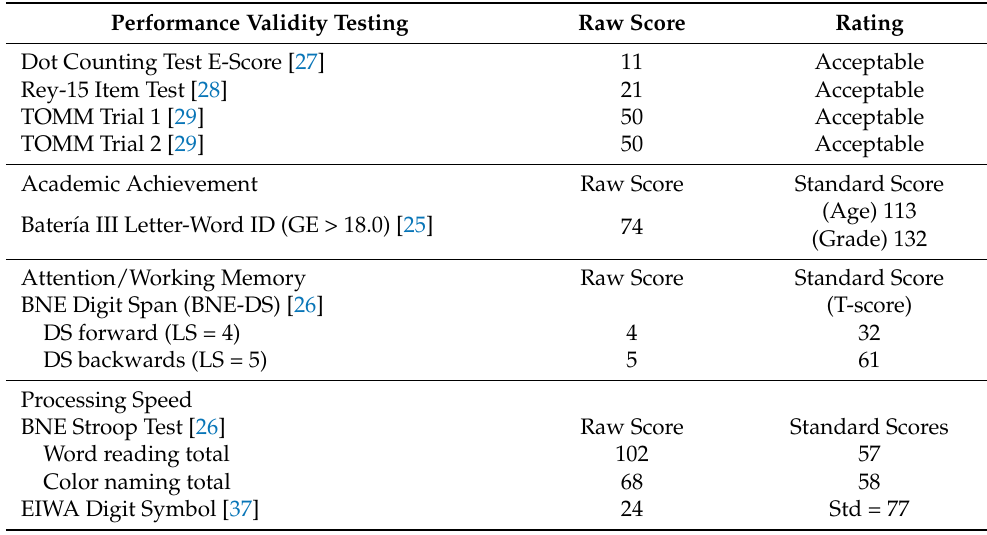
Table 1. Neuropsychological data